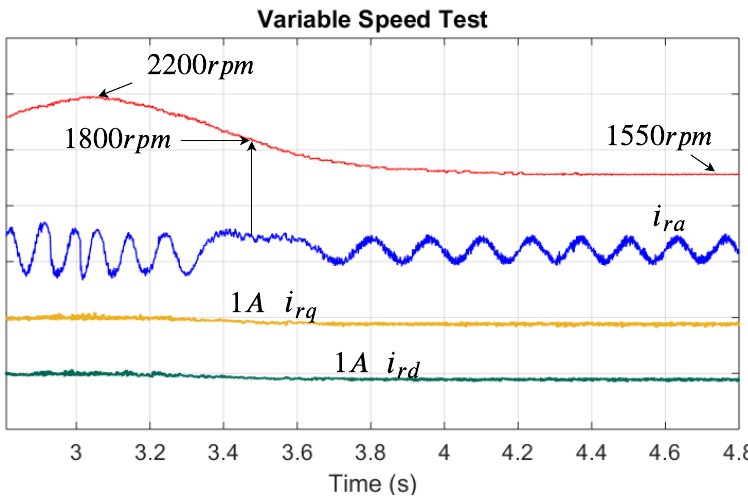
Figure 11. Variable rotor mechanical speed test from 1550 rpm to 2200